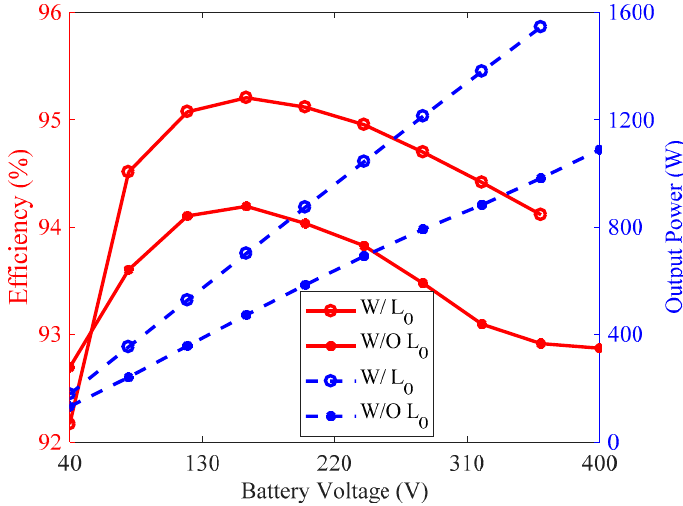
Figure 14. The output power and DC-DC efficiency varying with the battery voltage.